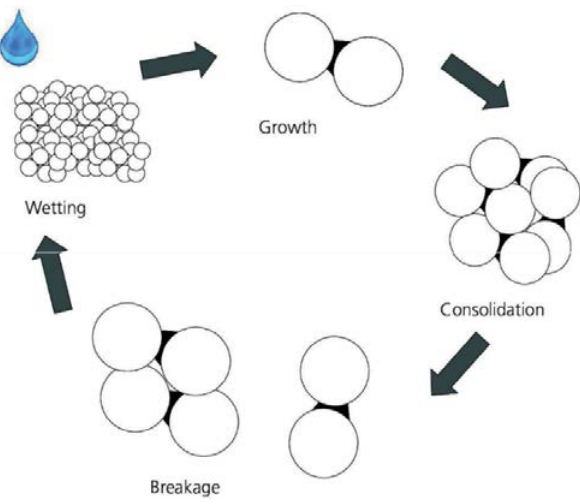
Fig. 1 . Key mechanisms of granulation